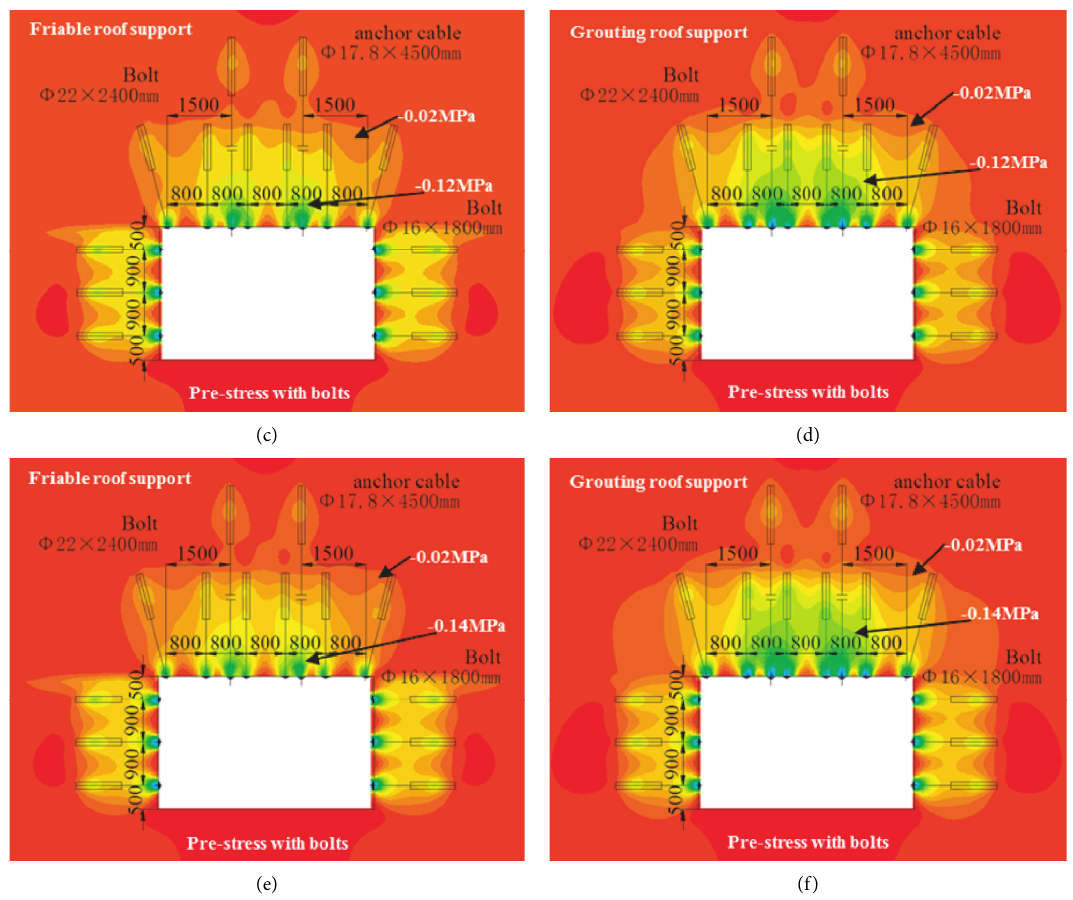
Figure 20: Distribution of the prestressed field of the grouting anchor cable. (a) Bolts with prestressed 60kN and anchor cables with prestressed 120kN. (b) Bolts with prestressed 90 kN and anchor cables with prestressed 150 kN. (c) Bolts with prestressed 120kN and anchor cables with prestressed 180